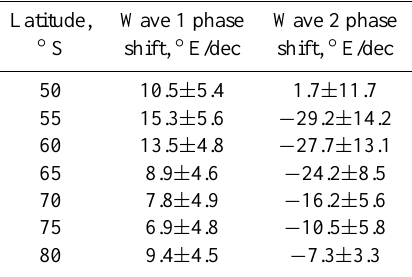
Table 3. Decadal change of the zonal wave 1 and 2